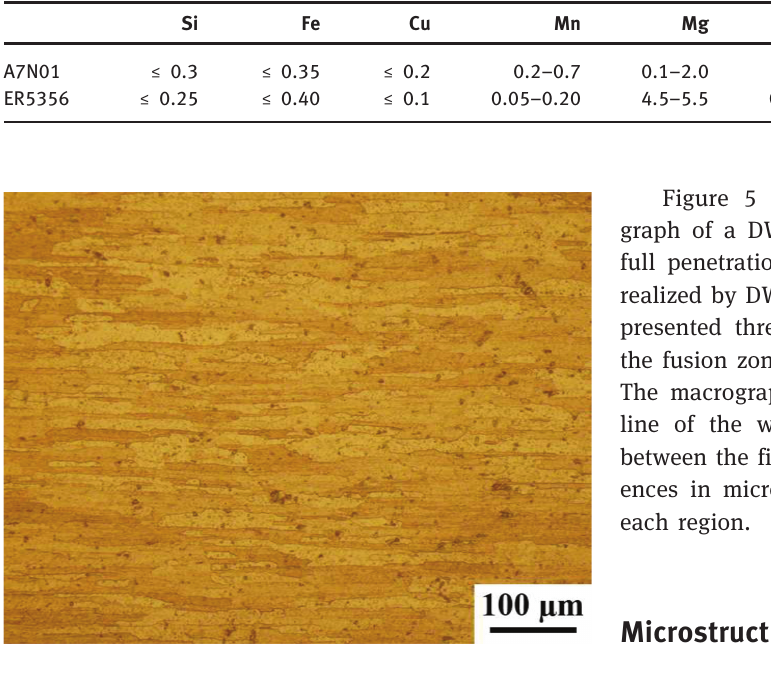
Figure 2: Micrographs of the BM A7N01-T4.